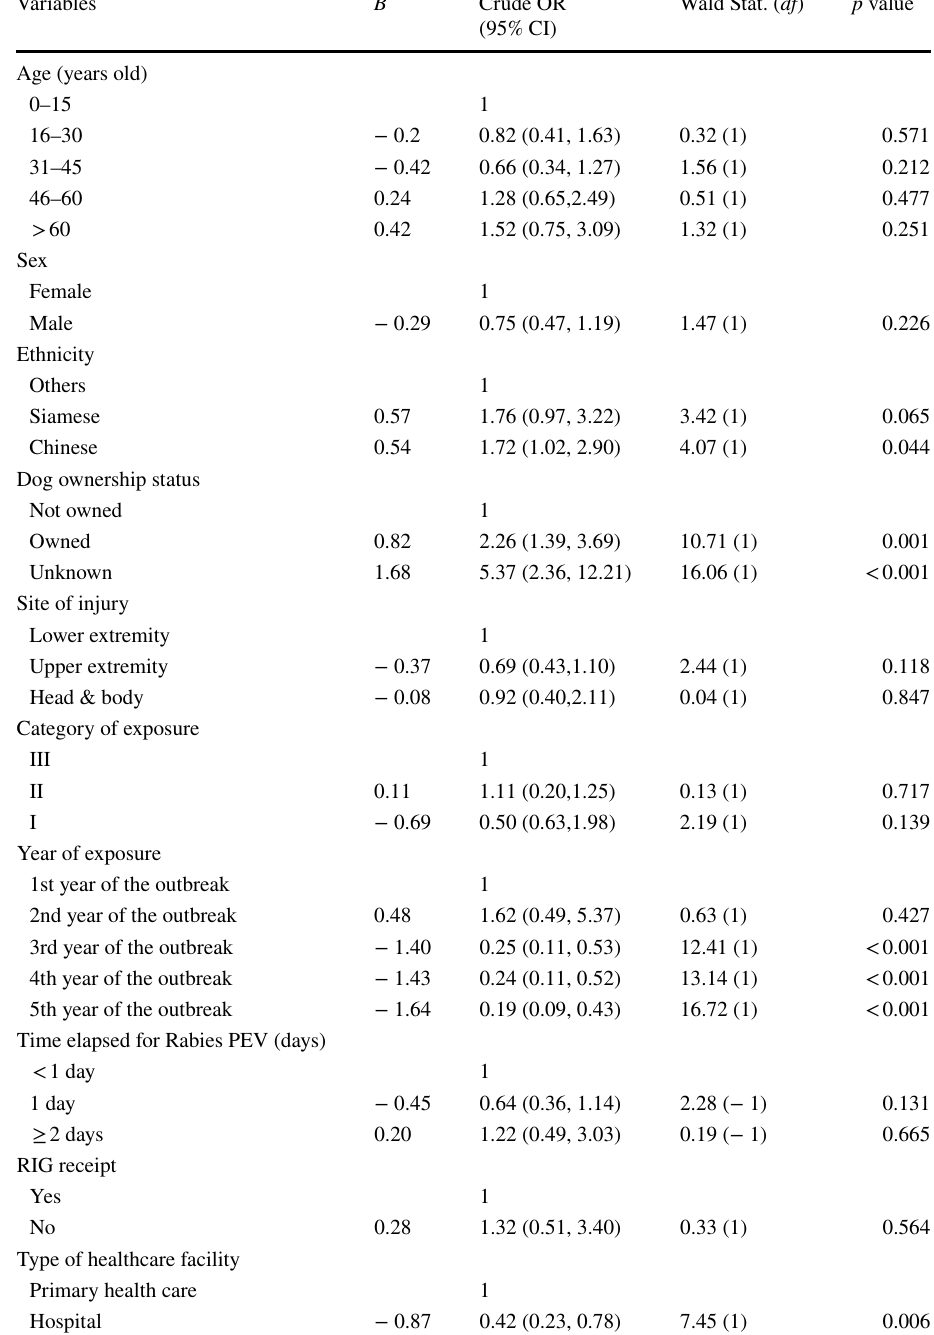
Table 2 Simple logistic regression of factors associated with non-compliance of Rabies PEV among dog bite patients in Perlis ( n = 507)